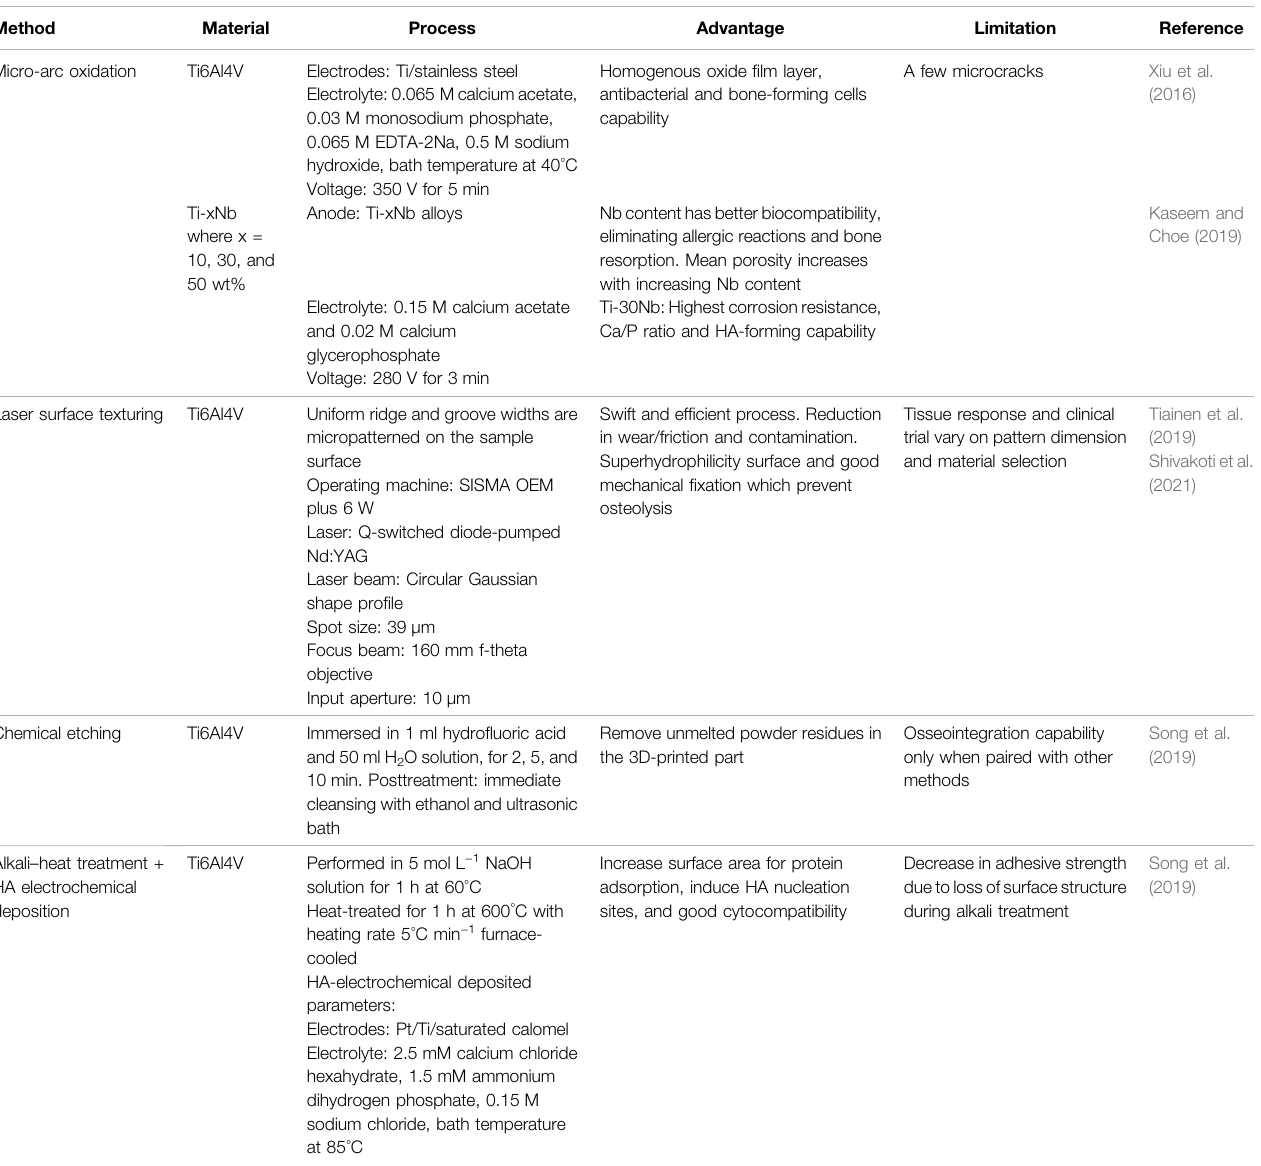
TABLE 1 | Summary of the bioceramic coating method and its limitation. Method